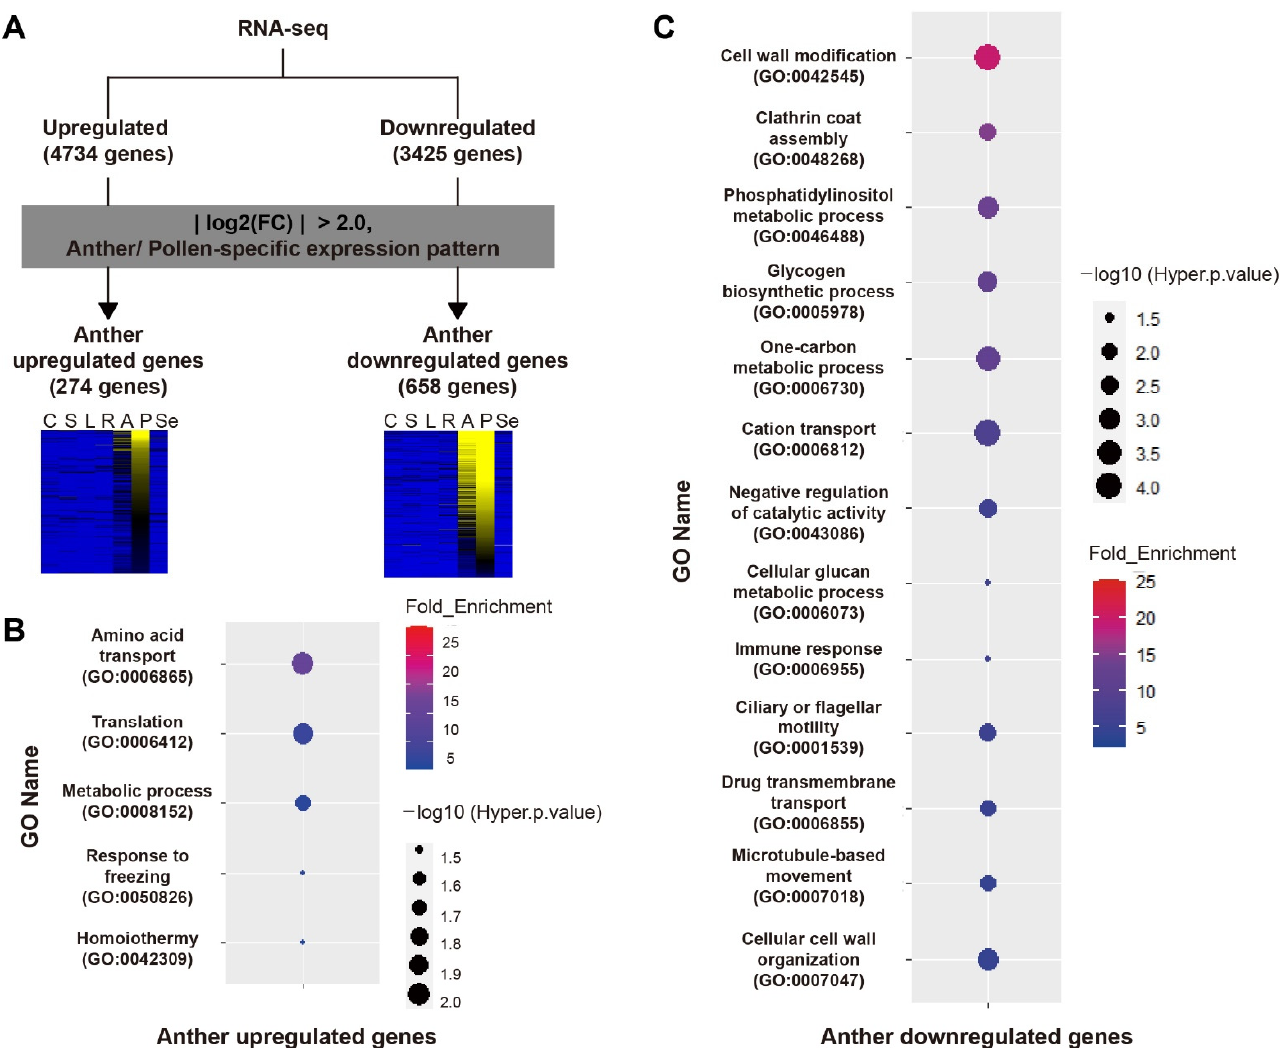
Figure 2. Schematic of DEG screening and GO annotation graph. ( A ) This schematic diagram shows how we screened Differentially Expressed Genes in mature pollen grains (pollen DEGs) after conducting RNA-seq. Four thousand, seven hundred and thirty-four upregulated genes and 3425 downregulated genes were selected, and the expression patterns of each tissue were compared, and the absolute value of log 2 ( FC ) was 2.0 or higher was selected in detail. Thus, 274 genes were finally selected as pollen upregulated genes and 658 genes as pollen downregulated genes. The heatmap was drawn based on the RNA-seq value of each tissue in wild-type plants, yellow indicates a high expression, and blue indicates a low expression. C, Callus; S, Shoot; L, Leaf; R, Root; A, Anther; P, Pollen grains, Se, Seed. ( B , C ) GO enrichment annotation of pollen DEGs. The color represents the fold enrichment of GO, and the size of the circle represents the hyper p- value. The GO number was written under GO Names (terms), sorted in descending order based on the fold enrichment.